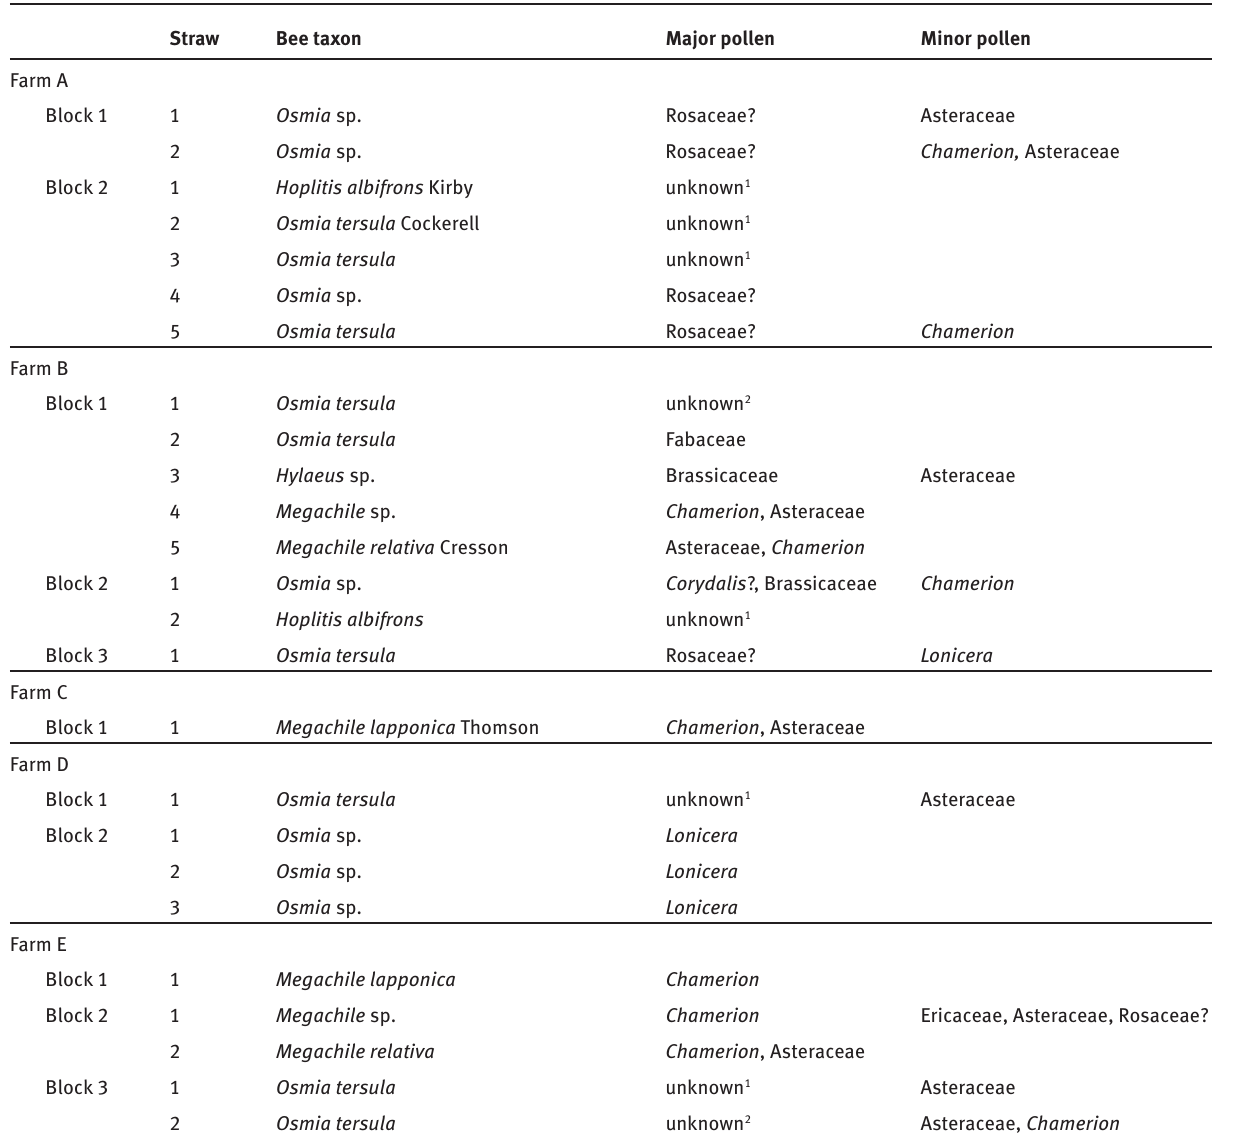
Table 2: Pollen associated with solitary cavity-nesting bees collected from bee blocks. A pollen taxon is considered a major component if it is >25% by volume in the sample examined and a minor component when <25% and >5%. Lonicera was haskap. Chamerion was Chamerion angustifolium (Onagraceae) . Some Osmia (Megachilidae), Hylaeus (Colletidae), and Megachile (Megachilidae) specimens could not be iden- tified to species because no emerging adults (or no emerging adults of the sex necessary for identification) were